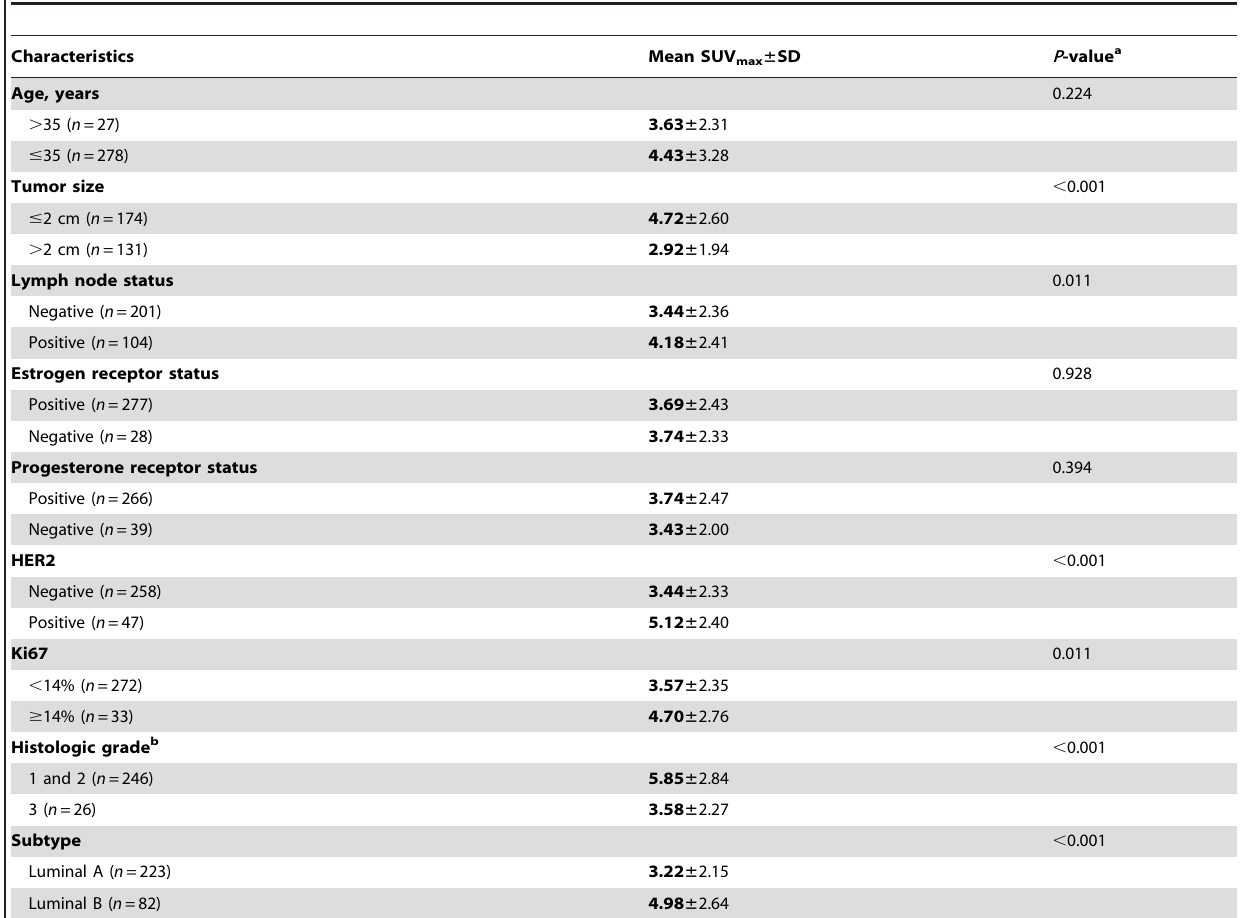
Table 3. Comparisons of SUV max according to tumor